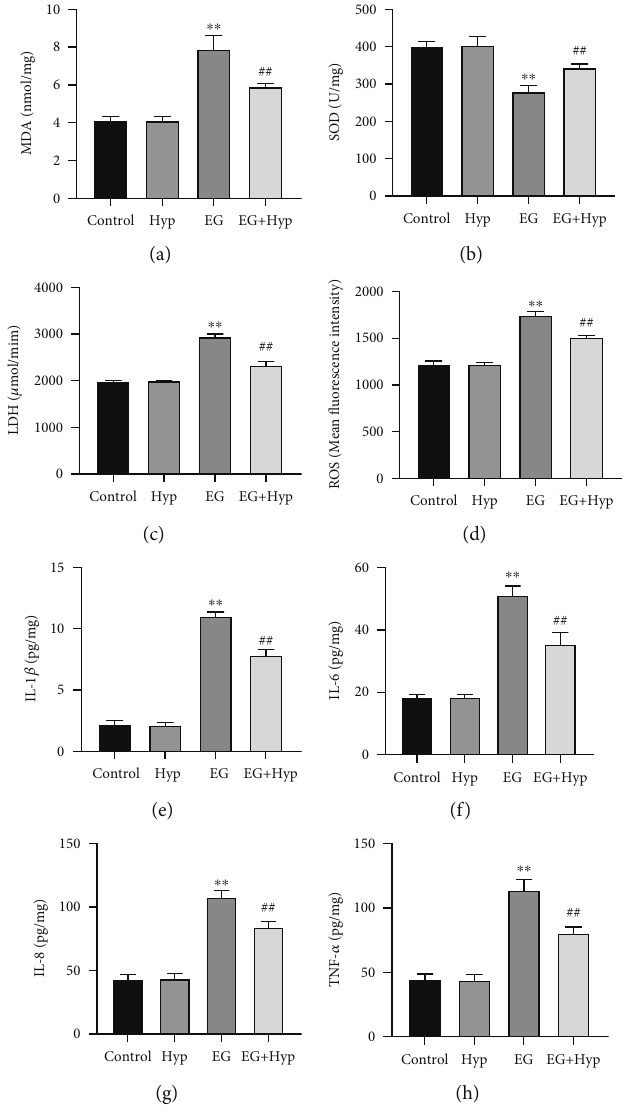
Figure 3: Role of hyperoside in ethylene glycol-induced oxidative stress injury and in fl ammatory response in rat kidney. (a – d) Biochemical detection of the levels of oxidative stress-related substances MDA (a), SOD (b), LDH (c), and ROS (d) in the kidney tissues of rats; (e – h) ELISA for detecting the levels of in fl ammatory cytokines IL-1 β (e), IL-6 (f), IL-8 (g), and TNF- α (h) in the kidney tissues of rats. ∗∗ P < 0 : 01 vs. control group, ## P < 0 : 01 vs. EG group. MDA: malondialdehyde; SOD: superoxide dismutase; LDH: lactate dehydrogenase; ROS: reactive oxygen